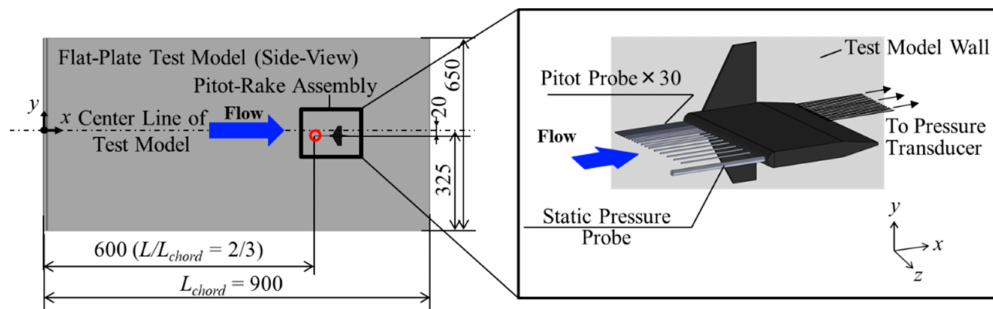
Figure 1. Schematic illustration of flat-plate test model ( left ), which was installed at the center of the wind tunnel duct and pitot-rake assembly ( right